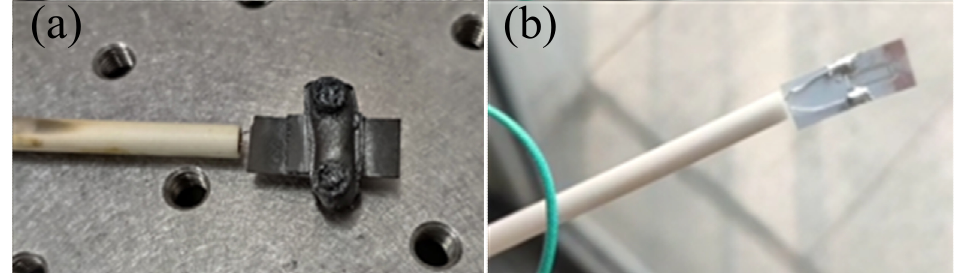
Figure 12. Oxidation deformation state of thermocouple under prolonged high temperature envi-